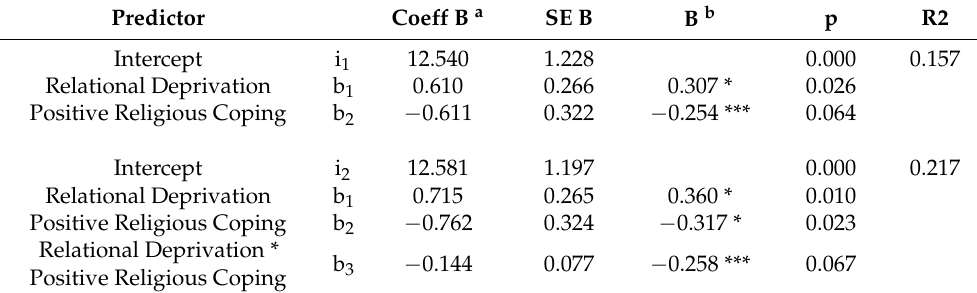
Table 4. Analysis of the moderating role of religious coping between relational deprivation and depression.